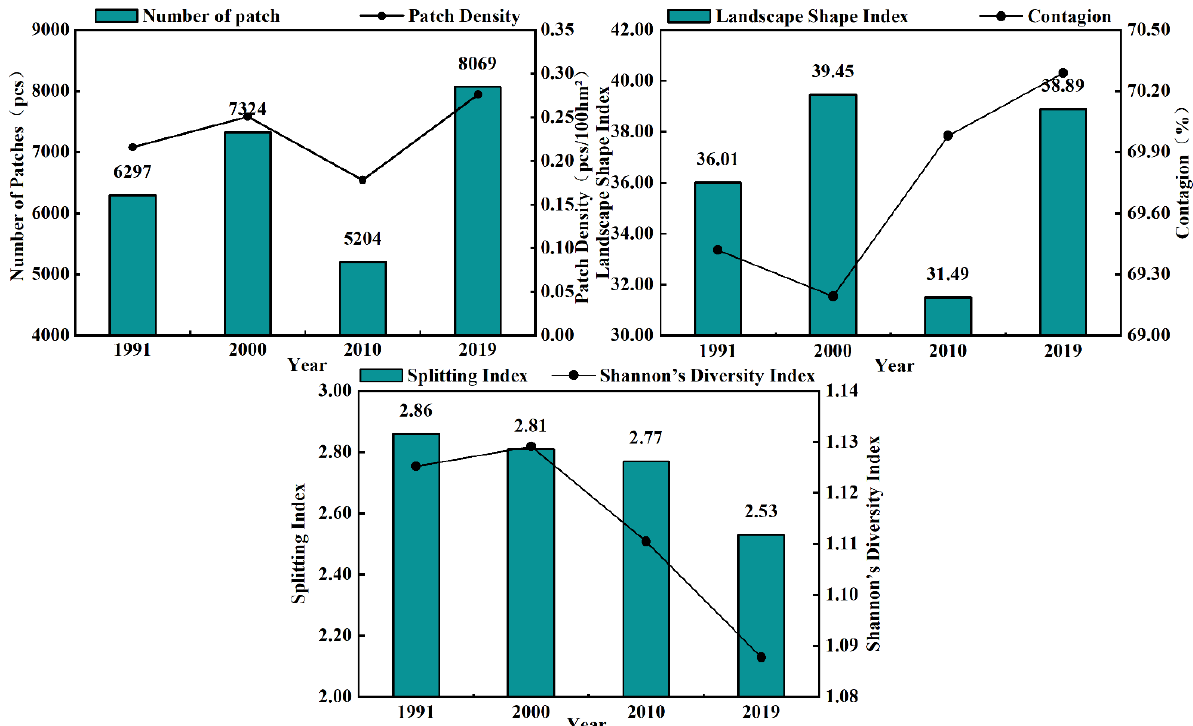
Figure 7. Changes in the landscape indexes (NP, PD, LSI, CONTAG, SPLIT, and SHDI) on the landscape scale along the Yellow River section of the Hobq Desert from 1991 to 2019.